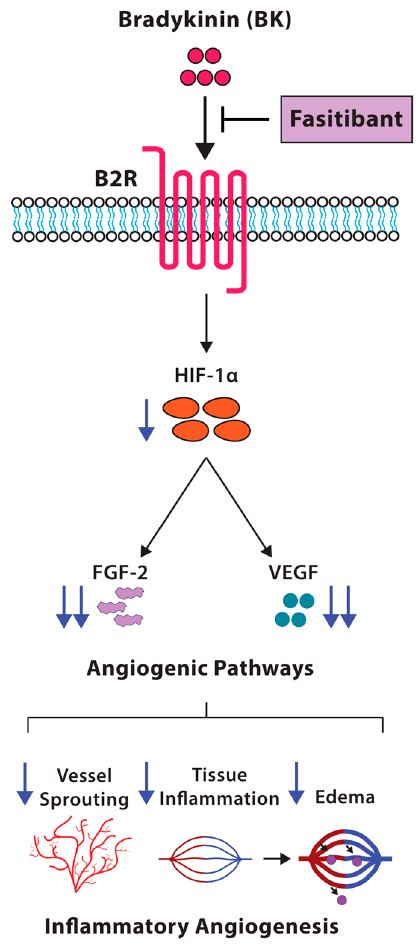
Figure 6. Schematic representation of the effects of inhibition of BK/B2R signaling on retinal vascularization. Fasitibant inhibits proangiogenic growth factor expression (FGF-2, VEGF, HIF-1 α ), reducing the inflammatory angiogenesis induced by BK/B2R signaling.